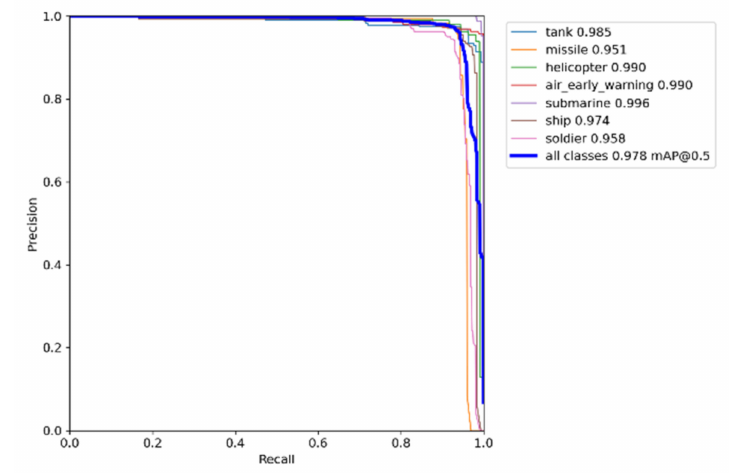
Figure 8. PR curve graph of the improved YOLOv5s model.